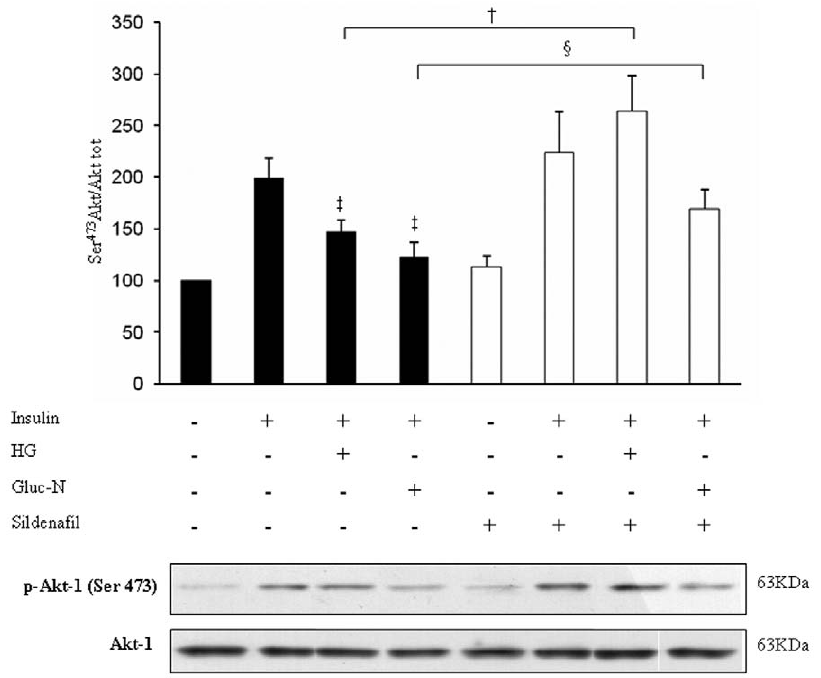
Figure 2. Akt-1 phosphorylation after sildenafil treatment. Insulin plus sildenafil treatment (1 m M/72 h) enhances Akt-1 phosphorylation in insulin resistance condition respect to the same conditions without sildenafil. Full bars represent conditions without sildenafil, dashed bars represent sildenafil treatment. Ctrl was expressed as 100%. Means 6 S.E. (n=5). { p , 0.05 vs insulin; { p , 0.05 vs HG + insulin; 1 p , 0.05 vs Gluc-N + insulin.